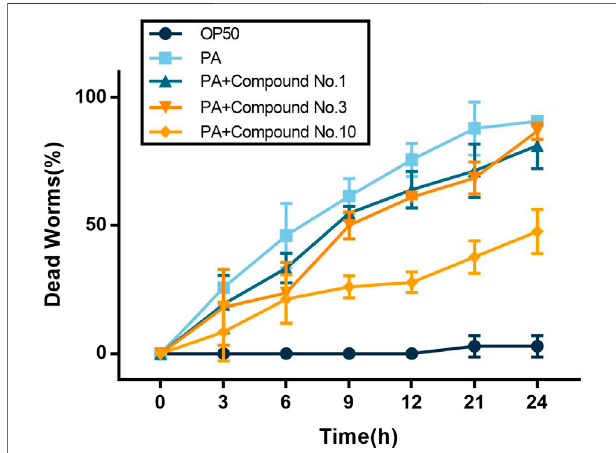
FIGURE7| Compoundno.3andcompoundno.10decreasedtoxicityof P. aeruginosa PAO1 in the C. elegans model.